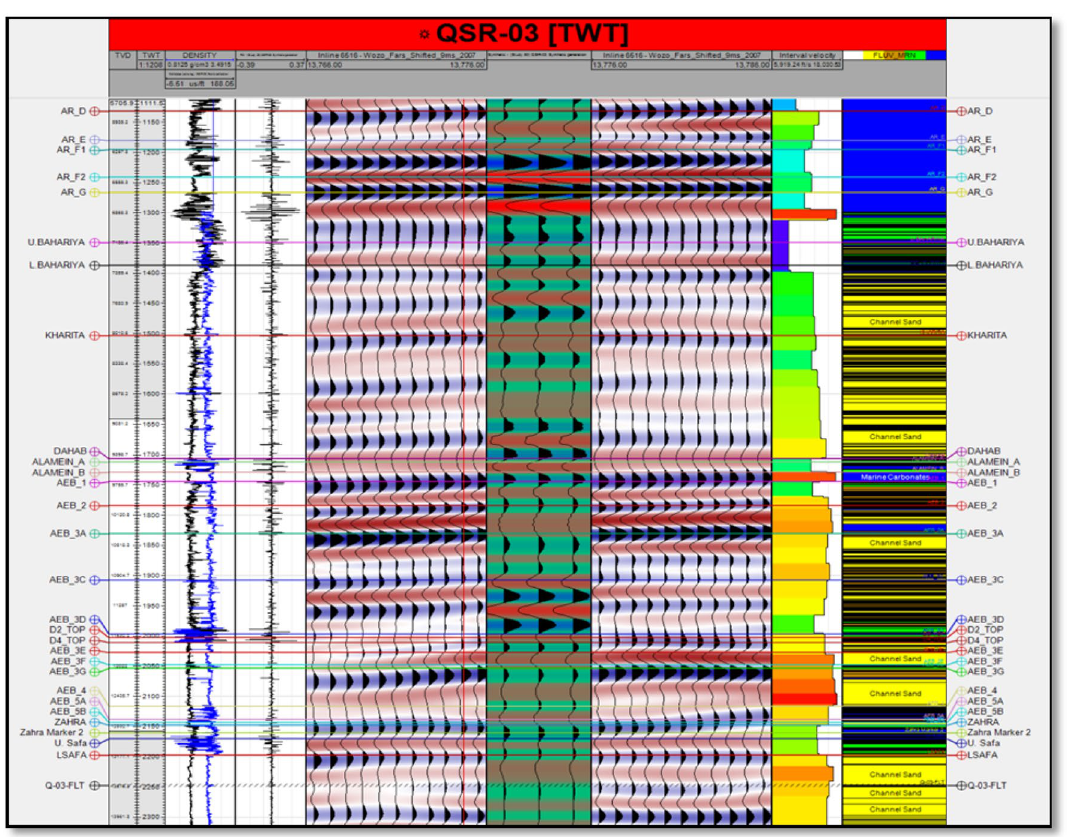
Fig. 9 Synthetic seismogram of well Qasr-03, depth–two-way-time (TWT) relationship with linear depth scale. Note that the sandstone is shown by yellow color on the lithology column to